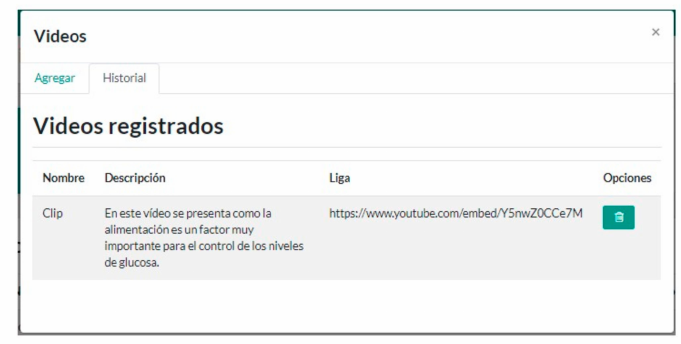
Figure 13. Administrator user interface: Check videos integrated into the system.